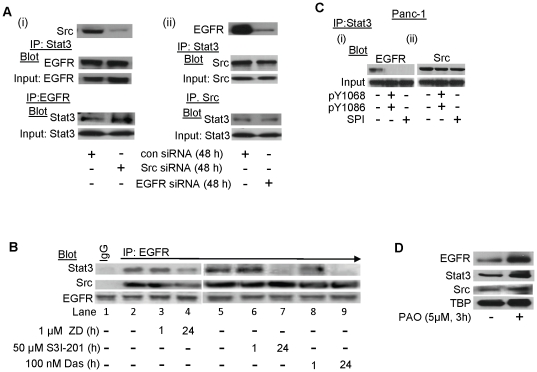
Co-immunoprecipitation with immunoblotting analysis of the effects of modulation of EGFR, Src and Stat3 on the nuclear EGFR, Src and Stat3 complex.(A, B, and C) Immunoblotting analyses of immunecomplexes of Stat3 (IP:Stat3), EGFR (IP:EGFR), or Src (IP:Src) prepared from nuclear extracts of Panc-1 cells untransfected or transfected with Src siRNA, EGFR siRNA, or control (con) siRNA (A), or treated with or without the EGFR inhibitor (ZD1839, ZD), Src inhibitor (Dasatinib, Das), or the Stat3 inhibitor (S3I-201) for 1 or 24 h (B), or from nuclear extracts pre-incubated for 2 h with or without 100 µM pY1068, pY1086, or SPI peptide (C) and probing for EGFR, Src, Stat3; or (D) immunoblotting analysis of nuclear extracts prepared from Panc-1 cells treated or untreated with phenylarsine oxide (PAO) and probing for Src, Stat3, EGFR. Bands corresponding to proteins in gel are shown; input: except where indicated, represents the immunoblotting for the respective immunoprecipitated protein in the same amount of lysate or nuclear extract used in the assay; Data are representative of 3 independent studies.